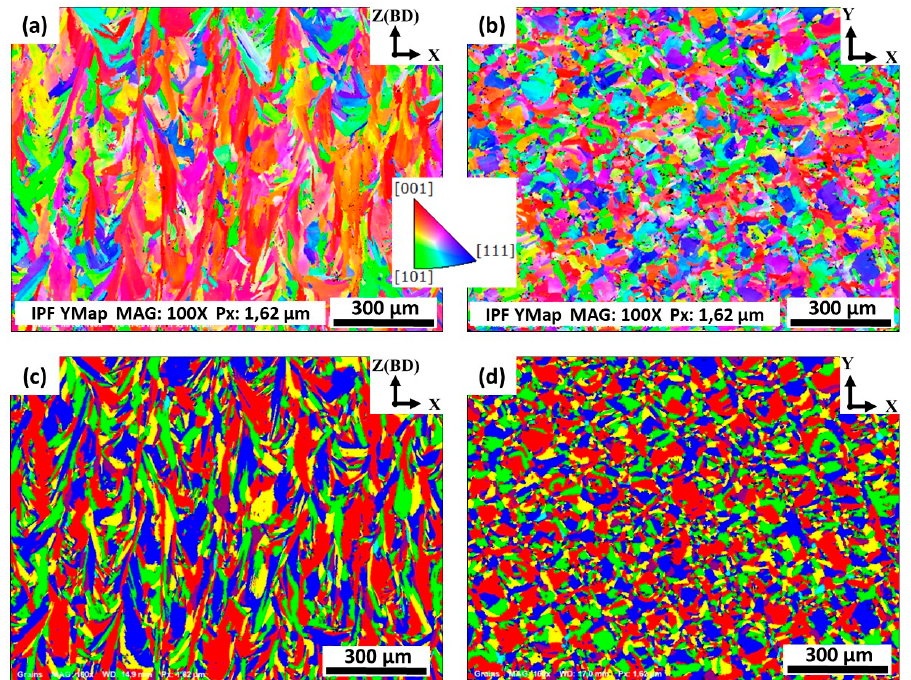
Figure 8. Inverse pole figures (IPF) ( a, b ) and grain maps ( c, d ) of the as ‐ printed laser powder bed fused IN718: ( a, c ) xz ‐ plane; ( b, d ) xy ‐ plane. The EBSD mappings of the as ‐ printed samples were IN718: ( a , c ) xz-plane; ( b , d ) xy-plane. The EBSD mappings of the as-printed samples were plotted using plotted using the y ‐ based projected IPF. the y-based projected